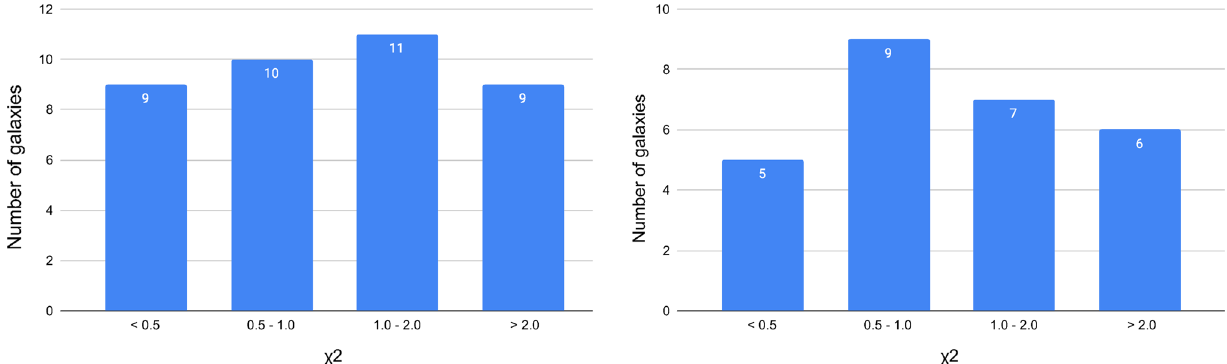
Fig. 7 The distribution of the χ 2 values, describing the accuracy of the fitting of the rotation curves for the full set of 39 considered galaxies (left panel), and for the 27 bulgeless galaxies (right panel)